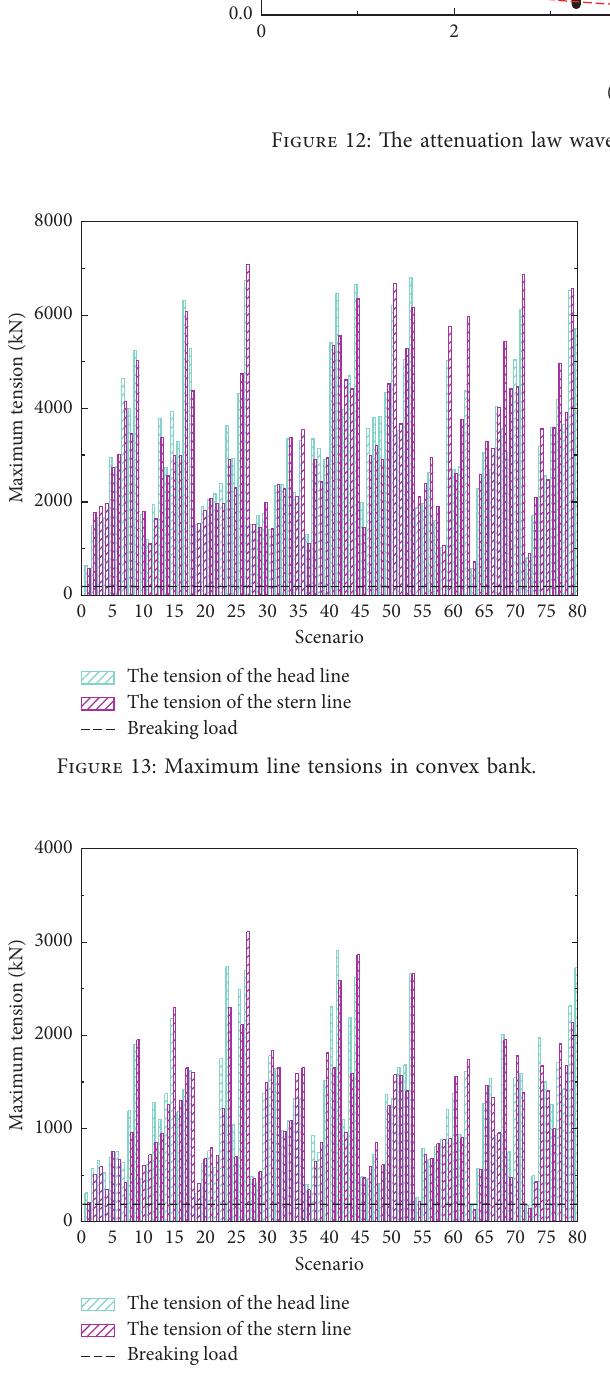
Figure 14: Maximum line tensions in concave